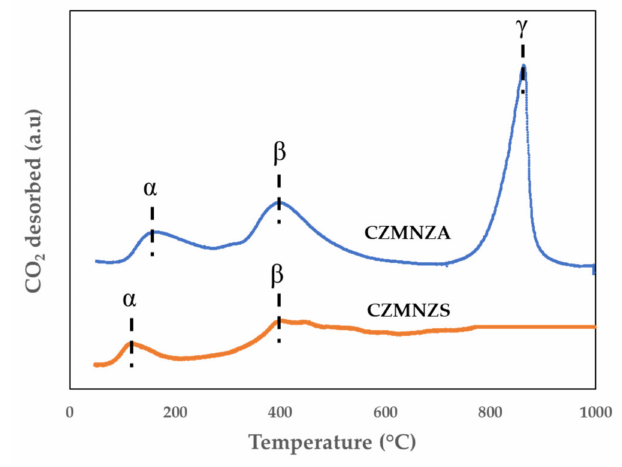
Figure 12. CO 2 -TPD profiles for CZMNZA and